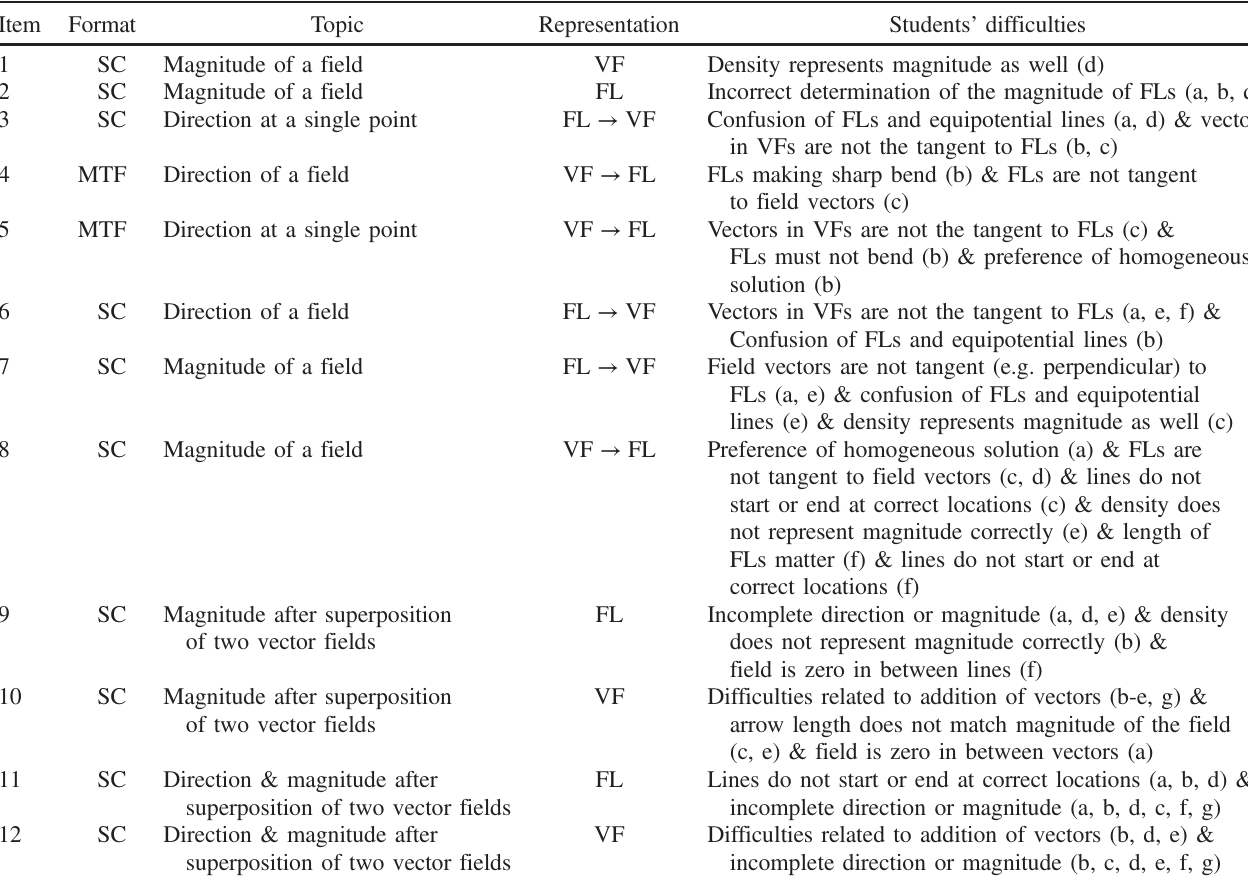
TABLE I. Overview of the items of the RCFI. The column labeled representation indicates the representation that is addressed in this item. The column labeled students ’ difficulties refers to the difficulties of students ([4,56]) that are addressed in the respective item. The letter in parenthesis refers to the respective distractor. FL → VF means that the task required the translation from a field-line (FL) representation to a vector-field (VF)